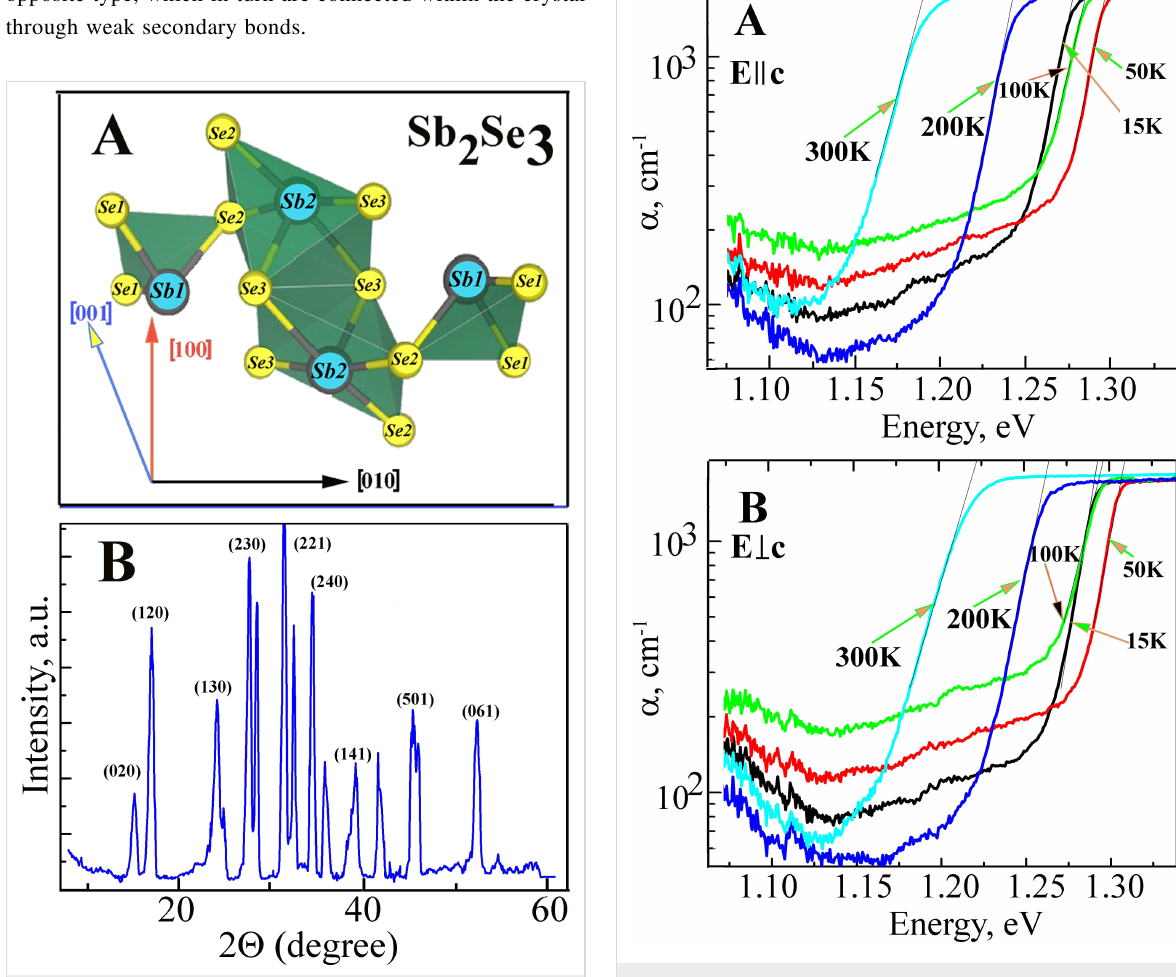
Figure 2: The absorption spectra of the Sb 2 Se 3 crystals, with thick- ness d = 113 µm, measured at different temperatures (300 K: cyan,